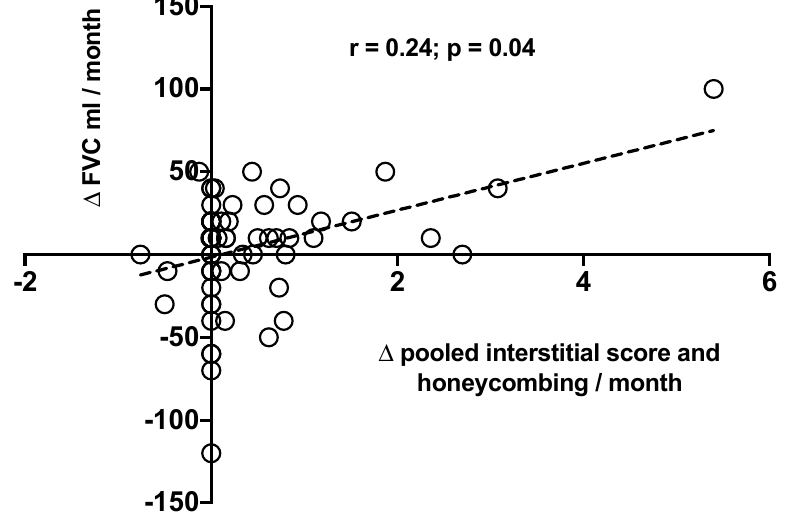
Figure 4. Correlation between change over time in FVC mL ( ∆ FVC mL / month) and change over time in the pooled Interstitial Score and Honeycombing ( ∆ pooled Interstitial Score and Honeycombing) in the entire study population. Negative values mean improvement of FVC.